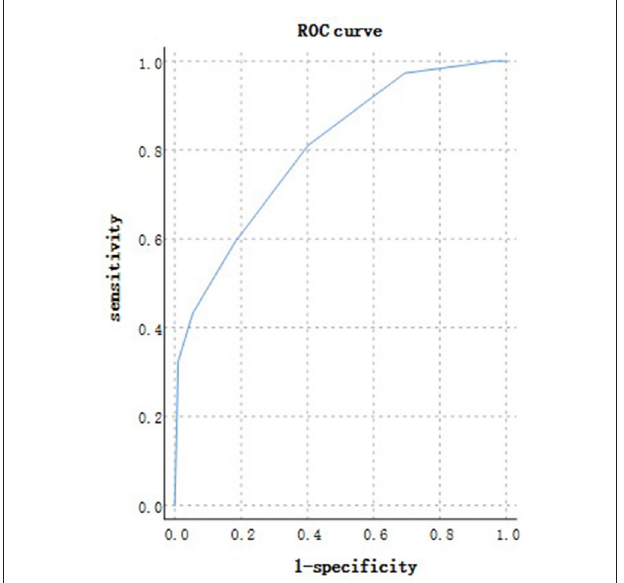
FIGURE 10 | Using age for discriminating the severe cases from the non-severe patients ( n = 718; non-severe and severe groups, n = 681 and 37, respectively). ROC analysis showing the performance of age in distinguishing severe cases from non-severe patients. ROC, receiver operating characteristic curve; AUC, area under the curve.